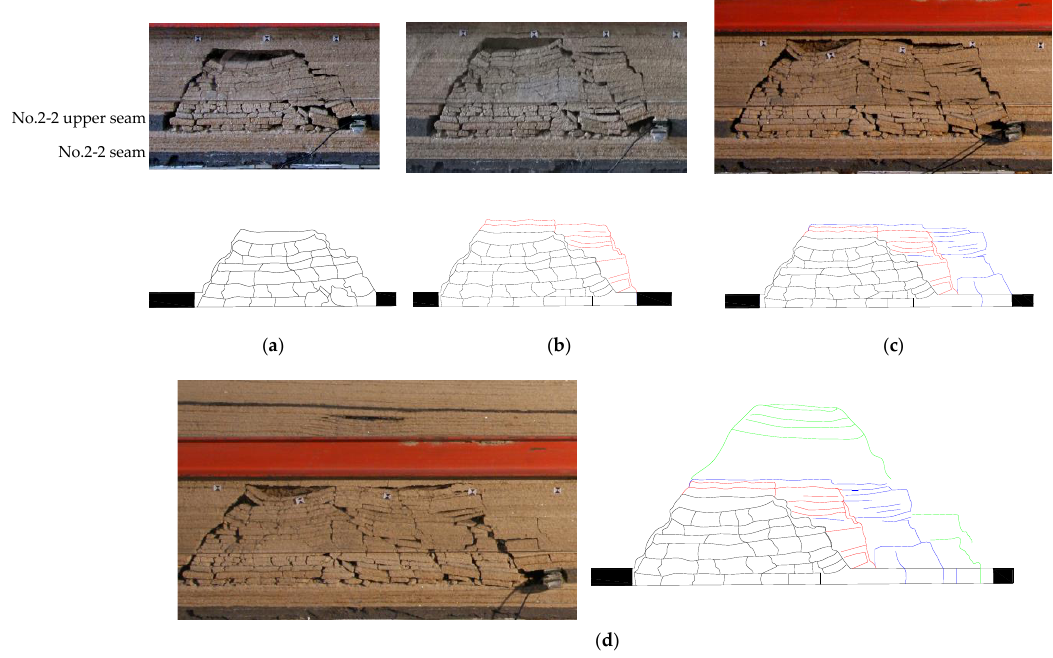
Figure 6. Crack development in different positions of 22102 working face: ( a ) advanced to 60 m, ( b ) advanced to 67.5 m, and ( c ) advanced to 80 m, and ( d ) advanced to 90 m.